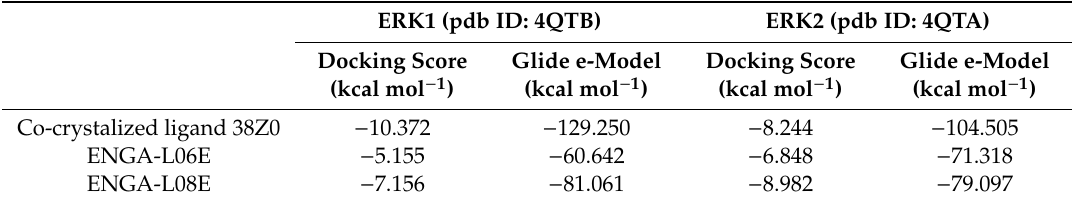
Table A6. Docking scores and Glide e-model in kcal / mol of molecules ENGA-L06E and ENGA-L08E compared to the co-crystal ligand 38Z0 in proteins ERK1 and ERK2.